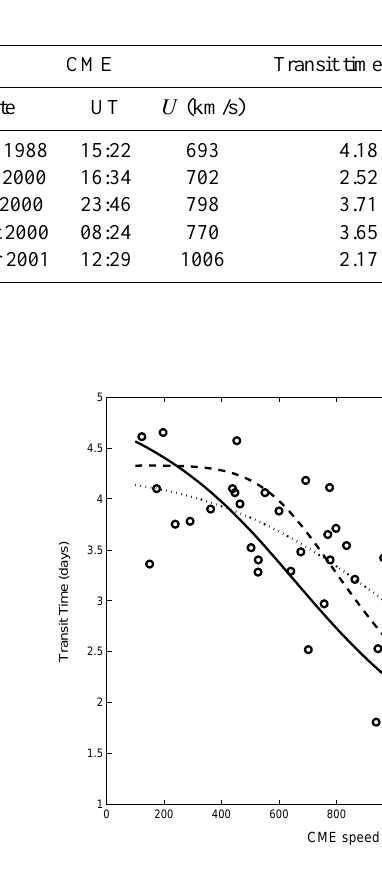
Fig. 2. The transit time of a CME to 1AU as a function of the CME speed for the 35 E-S line events. The solid, dashed and dotted lines represent the transit time predicted by models G2000, G2001 and VG2002,